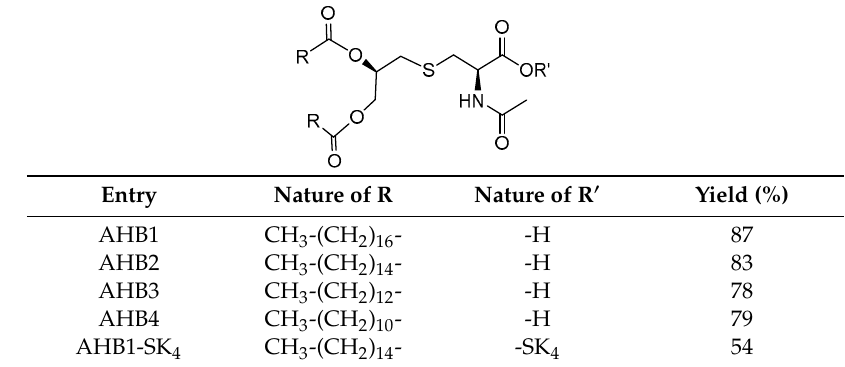
Table 1. Structures of various lapidated N-acetyl cysteine analogs analyzed for their TLR2/TLR6 agonist activity.